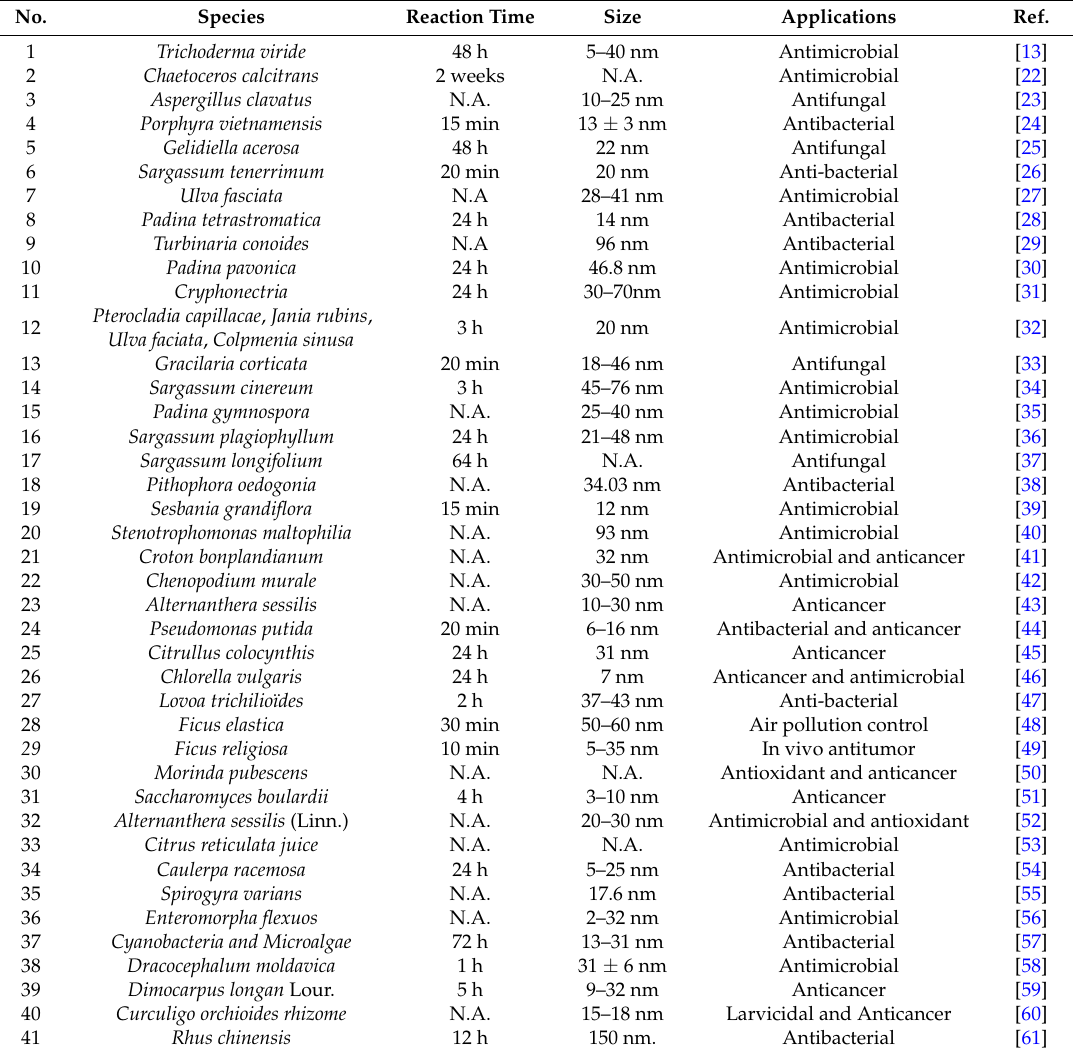
Table 1. Biosynthesized AgNPs using various